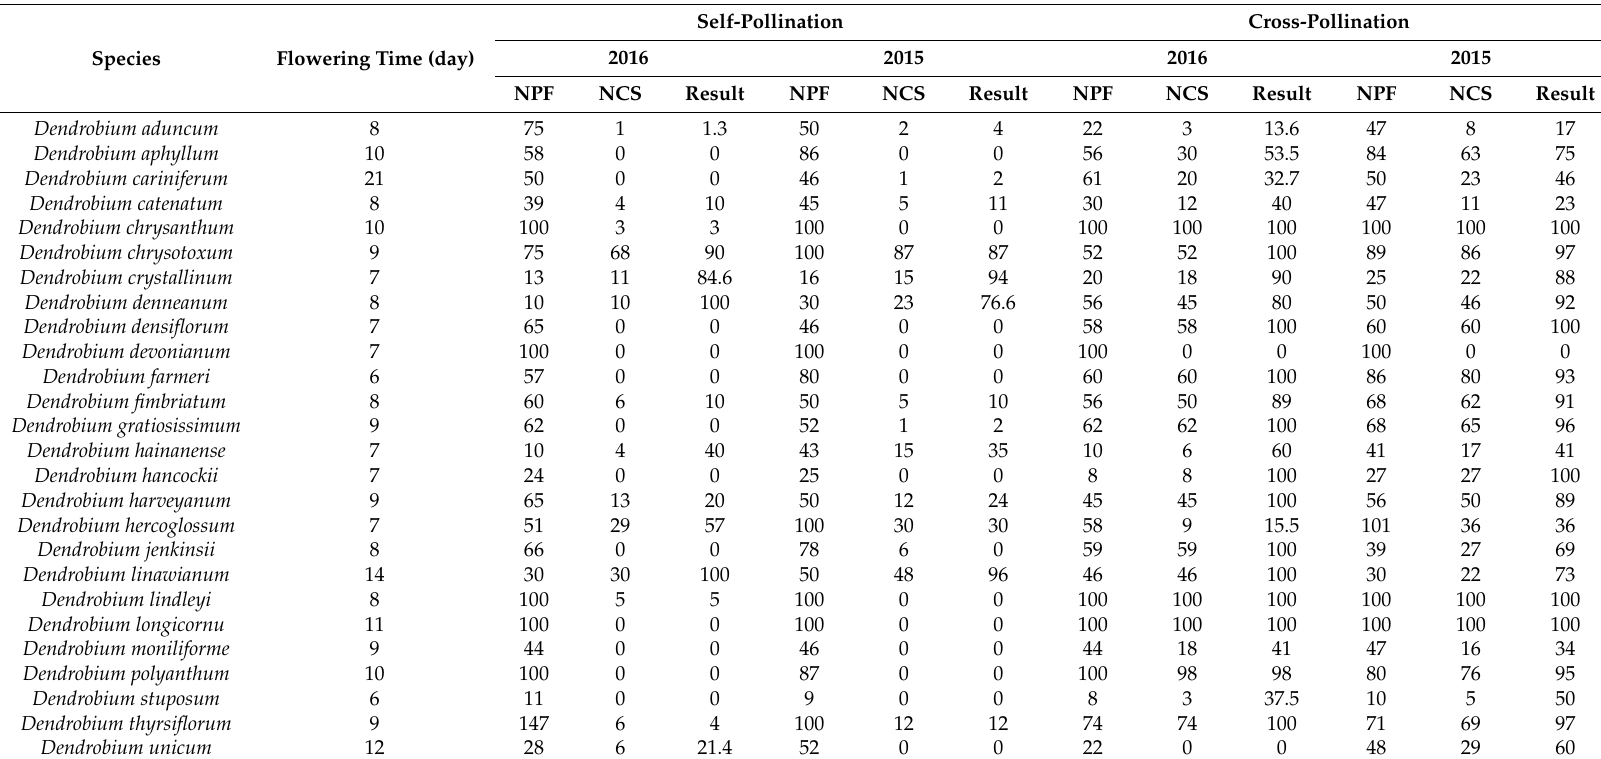
Table 1. Pollination results of experimental Dendrobium